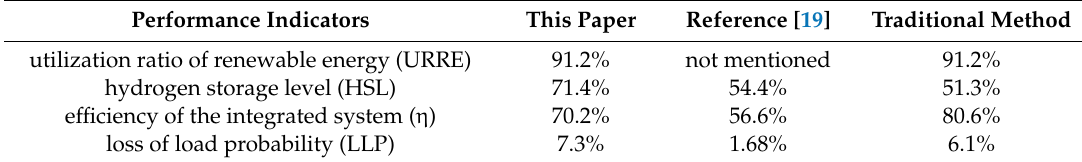
Table 3. Summary of experiment results.